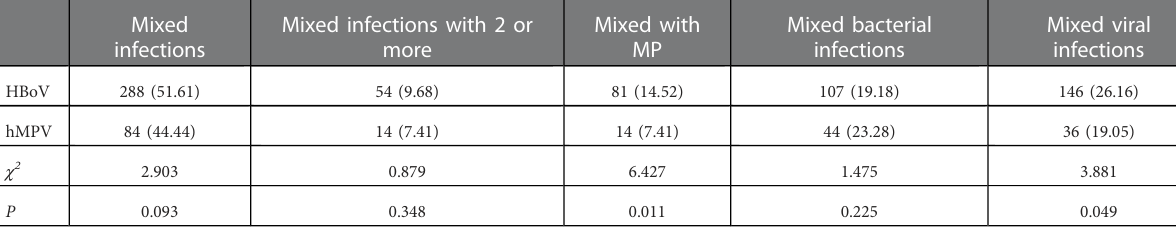
TABLE 4 Detection rate of mixed infections in both groups [ n (%)]. Mixed Mixed infections with 2 or infections more